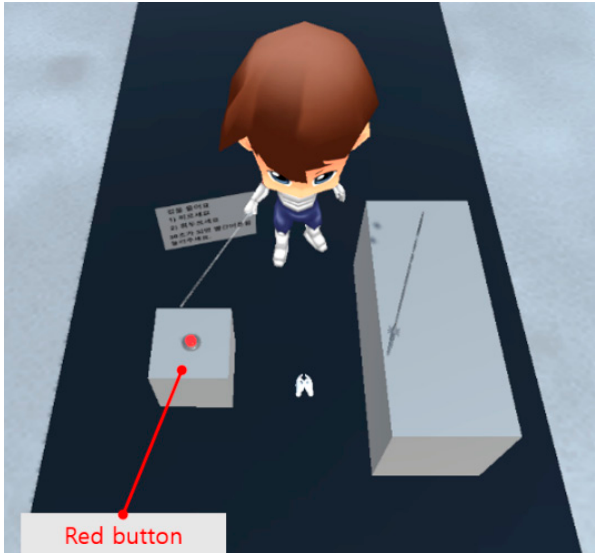
Figure 10. A new fencing game in which the user feels the tool pushed into the hand due to interaction with an object and in which centrifugal force can be felt when swinging the tool.